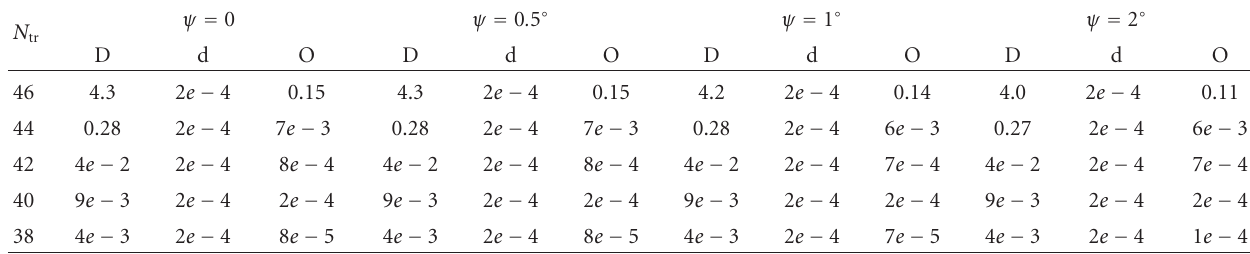
Table 6: Properties of M obtained with p = I . D is the maximum value occurring in the diagonal (all diagonal elements are positive), d is the minimum value occurring in the diagonal, and O is the maximum magnitude occurring away from the